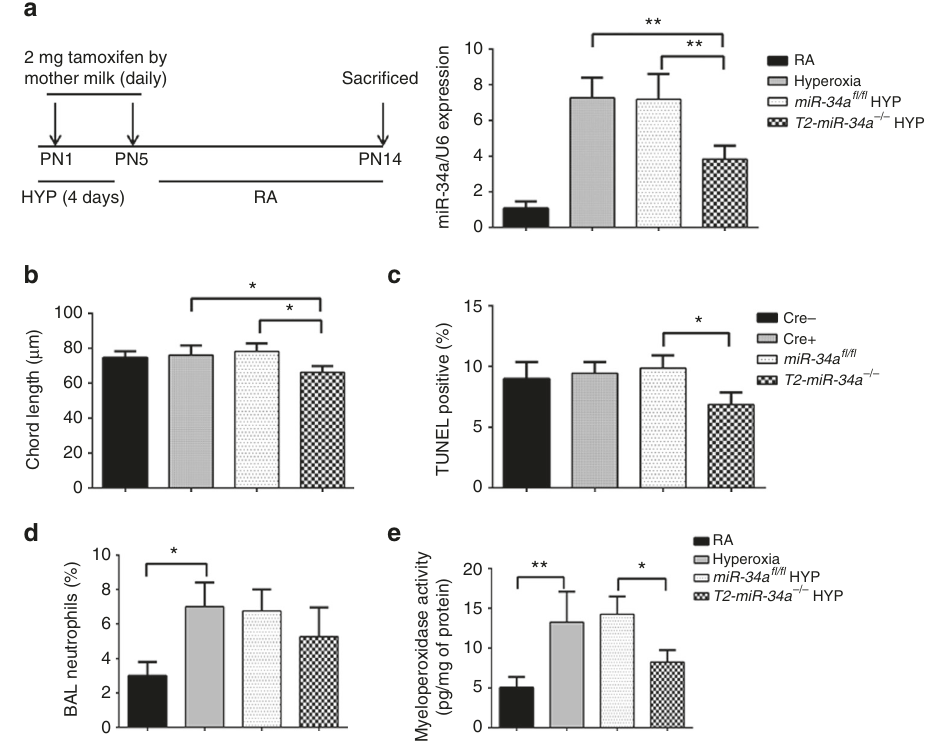
Fig. 6 Inducible deletion of miR-34a from type 2 epithelial cells improves BPD. a Schematic of tamoxifen-induced deletion of miR-34a in Spc CRE- expressing miR-34a fl / fl mice. From the birth of NB pups, dams were injected with 2 mg tamoxifen IP for four consecutive days (PN1-PN5). For the BPD model pups were kept in the hyperoxia chamber for 4 days and both dams (alternating in RA and hyperoxia exposure every 24 h) were given tamoxifen. Representative bar graph showing tamoxifen deletion of miR-34a in Spc CRE positive miR-34 KO lungs ( T2-miR34a − / − ). b Representative graph shows chord length analysis of lung histology (H&E stain) of NB T2-miR34a − / − mice BPD model along with controls. c Bar graphs showing less TUNEL count of lung histology sections of NB T2-miR34a − / − mice BPD model, as compared to controls. d , e BAL neutrophils count and myeloperoxidase activity were reduced in NB T2-miR34a − / − mice BPD model, as compared to controls. BPD: bronchopulmonary dysplasia; Spc: surfactant protein c ; NB: newborn; IP: intraperitoneal; PN: postnatal; RA; room air; KO: knockout or null mutant; T2: type 2 alveolar epithelial cells. Values are means ± SEM of a minimum four animals in each group. *P < 0.05, **P < 0.01, 2-way ANOVA, Tukey ’